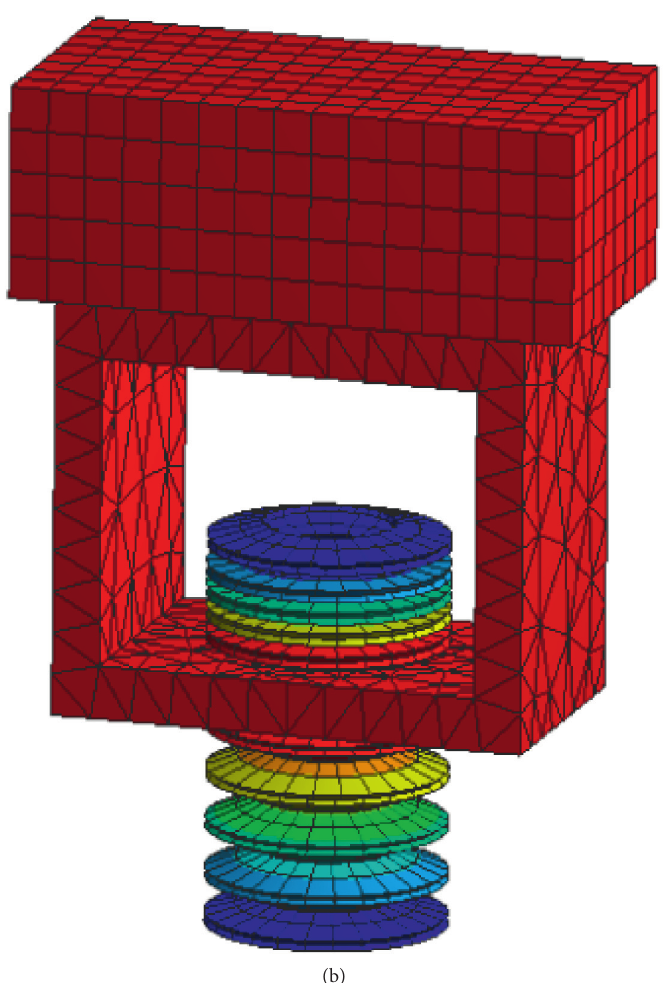
Figure 6: Third-order mode shapes of the disc spring system with 10 springs under locking and no preloading: (a) experiment and (b) simulation.